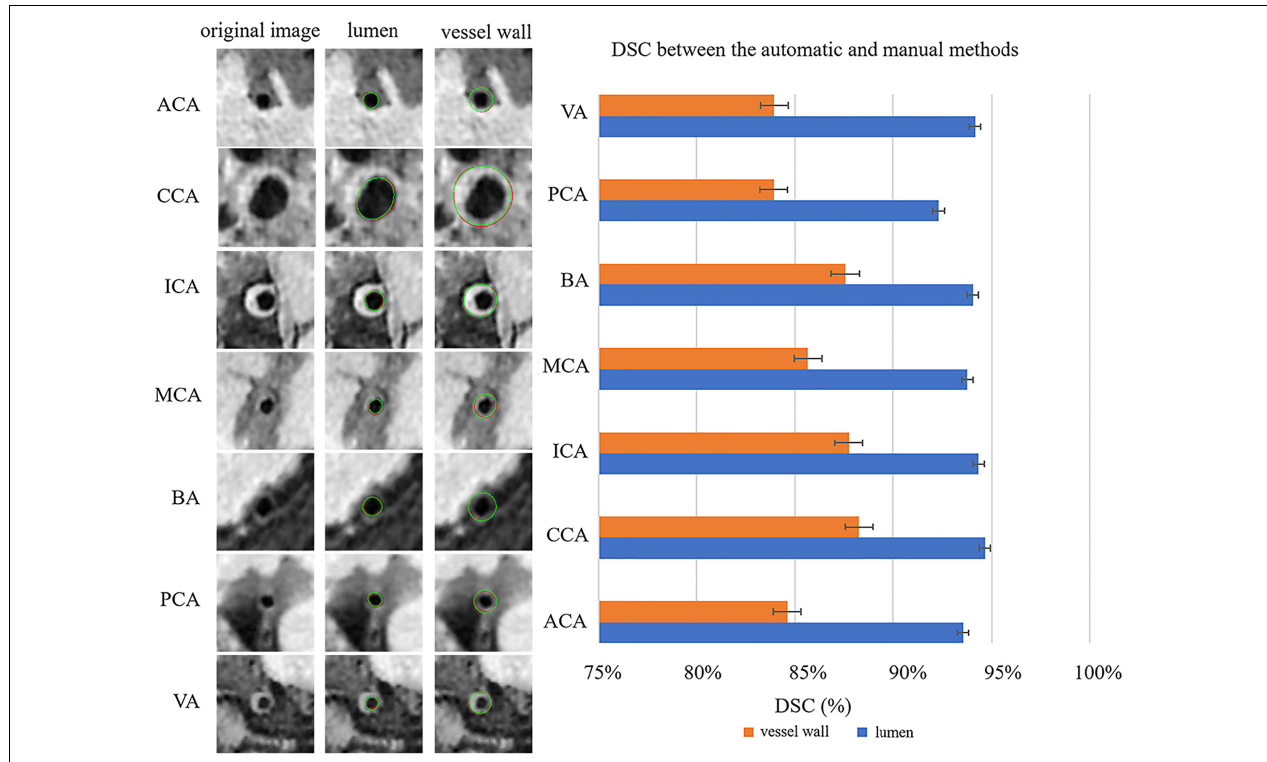
FIGURE 4 | Representative images and DSCs between the automatic and manual methods for the seven arterial segments. On the left, the first column represents the original cross-sectional slices reconstructed from MR vessel wall images; in the second column, the red contours represent the automatic segmentation results of the lumen, and the green contours represent the manual segmentation results of the lumen. In the third column, the red contour represents the automatically segmented results of the outer vessel wall, and the green contour represents the manual segmentation results of the outer vessel wall. The DSCs of the seven arterial segments are shown on the right using a bar